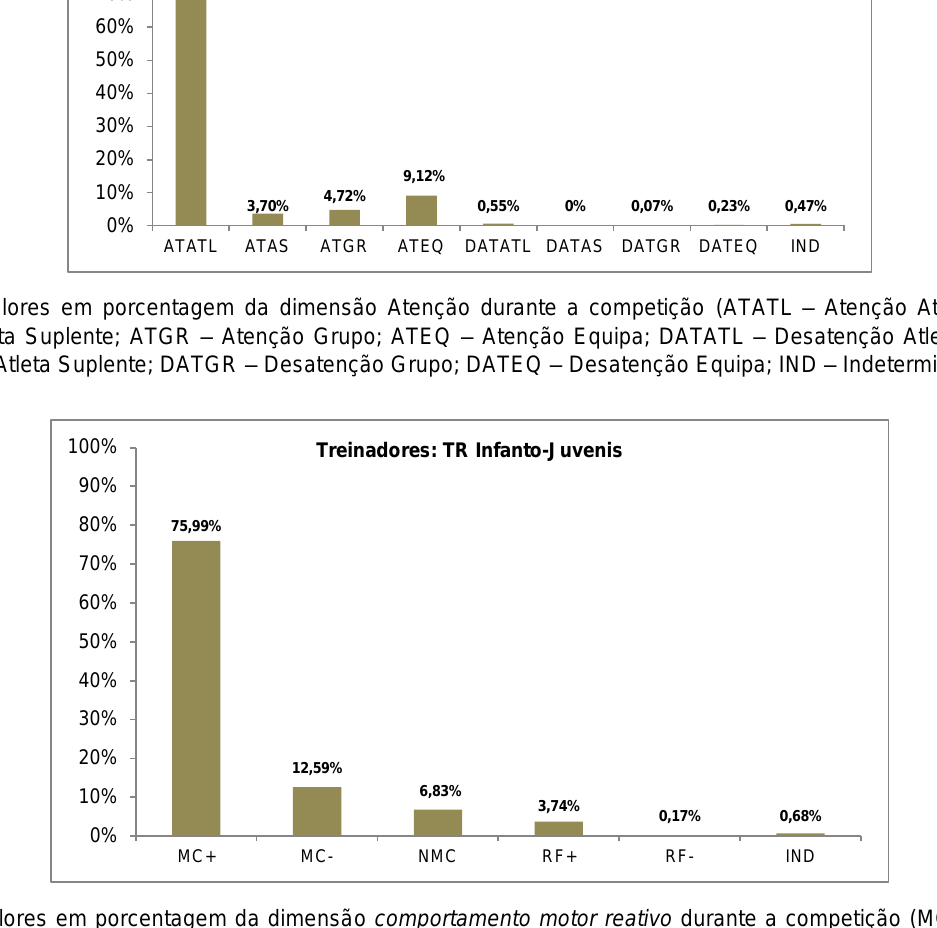
Figura 4. Valores em porcentagem da dimensão comportamento motor reativo durante a competição (MC+ - Modifica Comportamento Positivamente; MC- - Modifica o Comportamento Negativamente; NMC – Não Modifica o Comportamento; RF+ - Reforço Positivo; RF- - Reforço Negativo, IND –